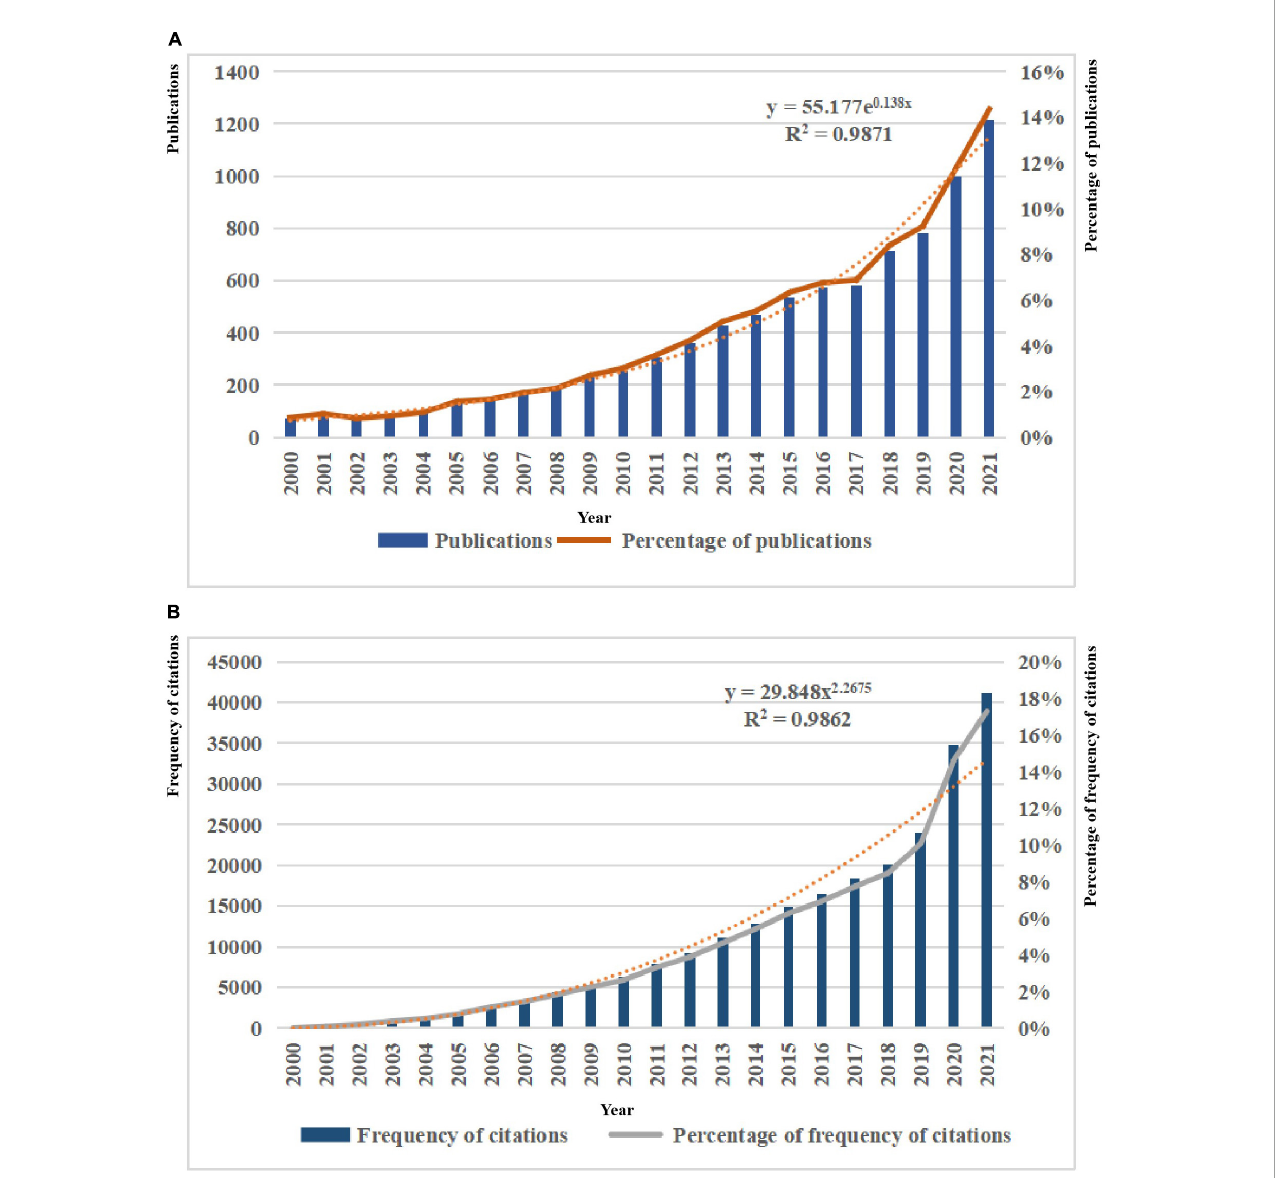
FIGURE2 (A) Trends in the number of publications on the application of artificial intelligence in sepsis from 2000 to 2021. (B) Trends in the number of frequency of citations on the application of artificial intelligence in sepsis from 2000 to 2021.